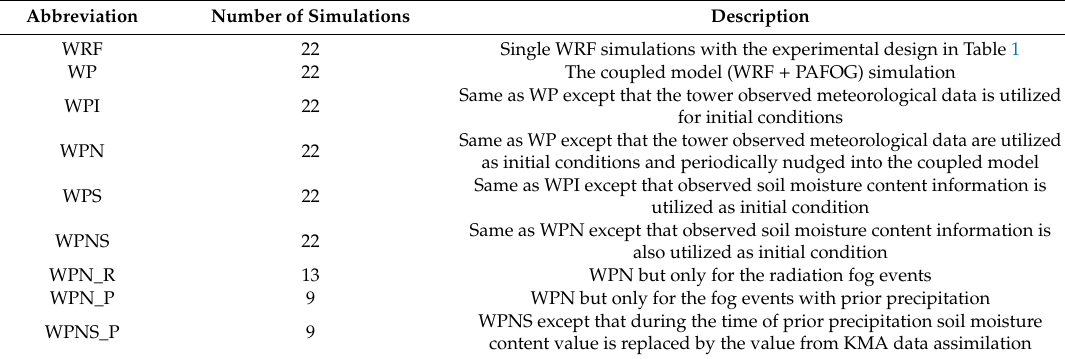
Table 3. Description of di ff erent numerical simulation